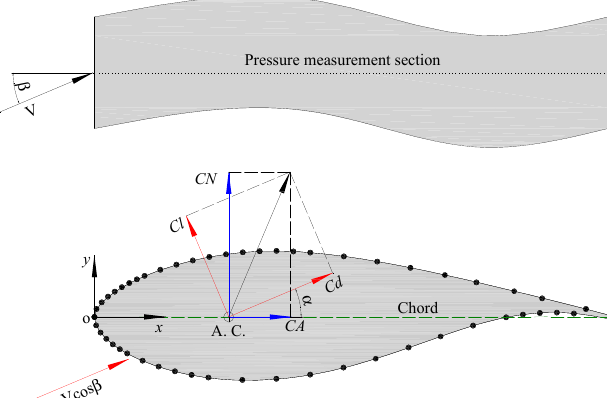
Figure 8. Sketch diagram of the body-axis and air-axis force.